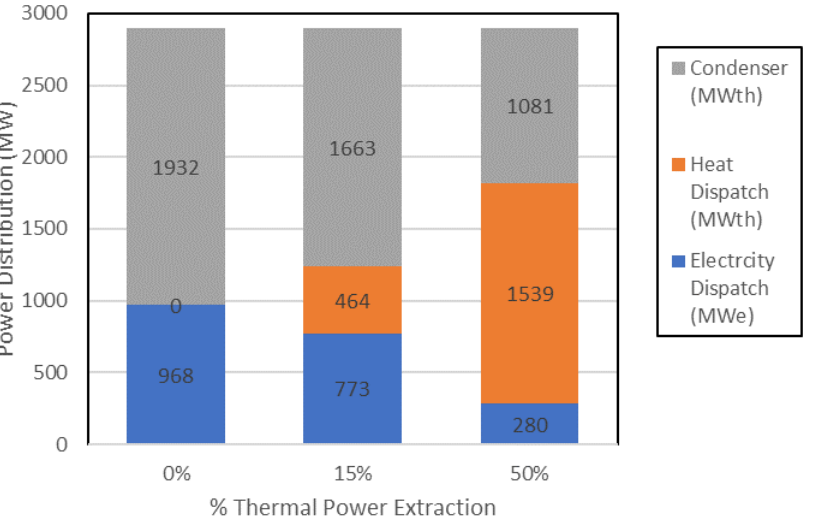
Figure 5. Summary of thermal power destination for pure electric power dispatch and mixed-mode operations with 15% and 50% thermal power